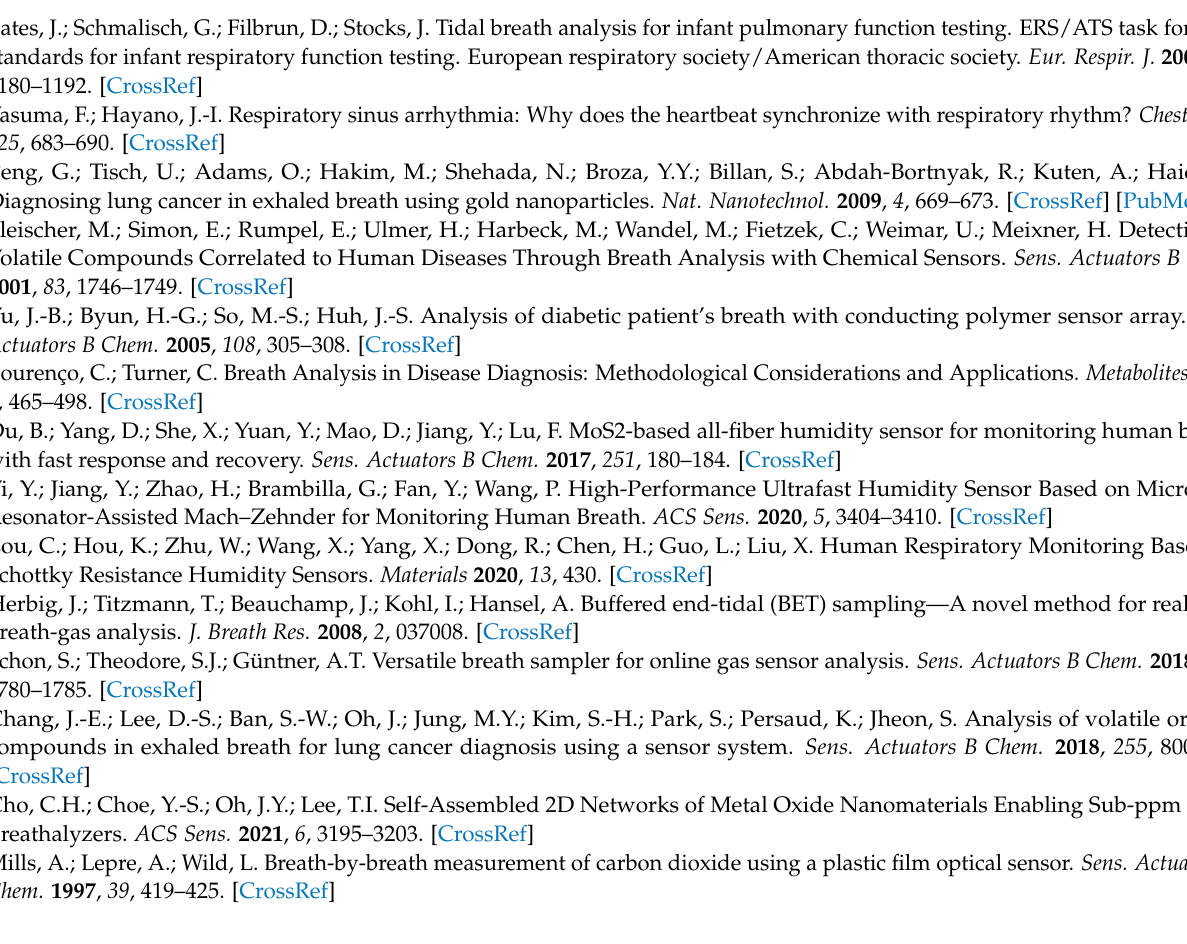
Figure S2: Schematic illustration of the experimental setup for the laser direct patterning process; Figure S3: Atomic force microscopy (AFM) image of the single Ni/NiO x electrode; Figure S4: SEM images of (a) the as-synthesized NiO x thin film and (b) NiO x as the sensing channel; Figure S5: SEM image of the sensor at a high magnification; Figure S6: Schematic illustration of humidity sensing mechanism; Figure S7a: Response of the breath sensor to CO 2 gas: Figure S7b: Response of the breath sensor to humidity; Table S1: Performance comparison of the breath sensors for different materials reported in the literature and in this study: Video S1: A video clip showing the response of the sensor to the human